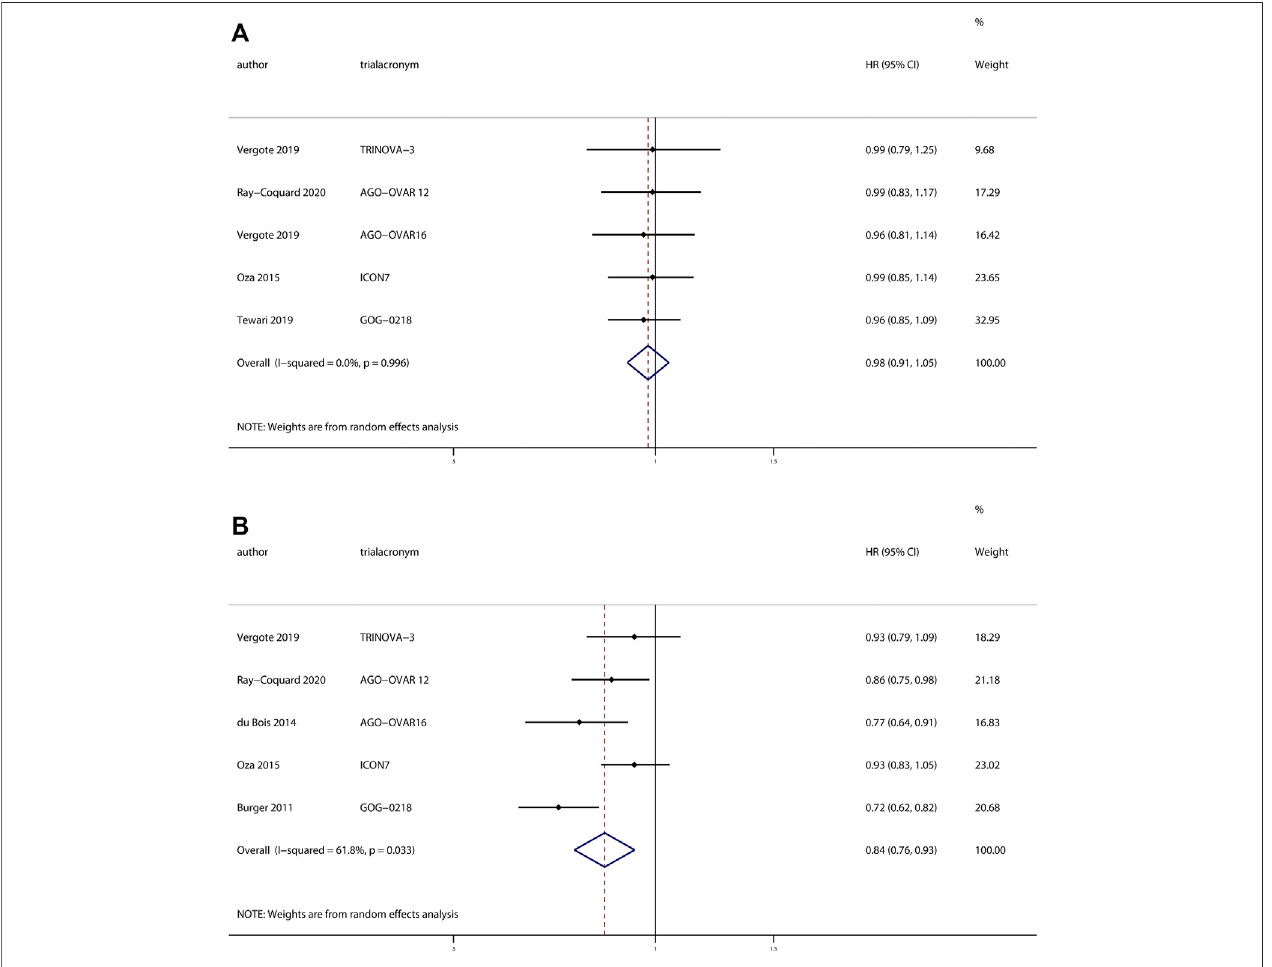
FIGURE 2 | Anti-angiogenesis maintenance treatment vs placebo in newly diagnosed ovarian cancer. (A) Overall survival (OS). (B) Progression-free survival (PFS).